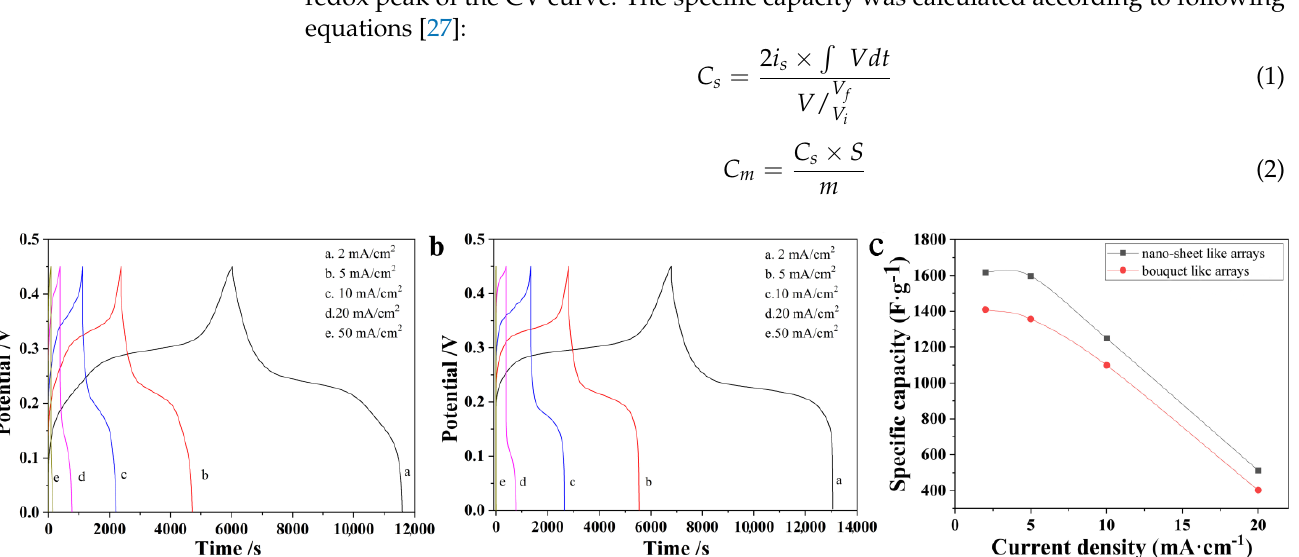
Figure 5. GCD curves of ( a ) MHP bouquet arrays/ACF composite electrode; ( b ) MHP nano-sheet arrays/ACF composite electrode; ( c ) Specific capacity of MHP/ACF composite electrode.